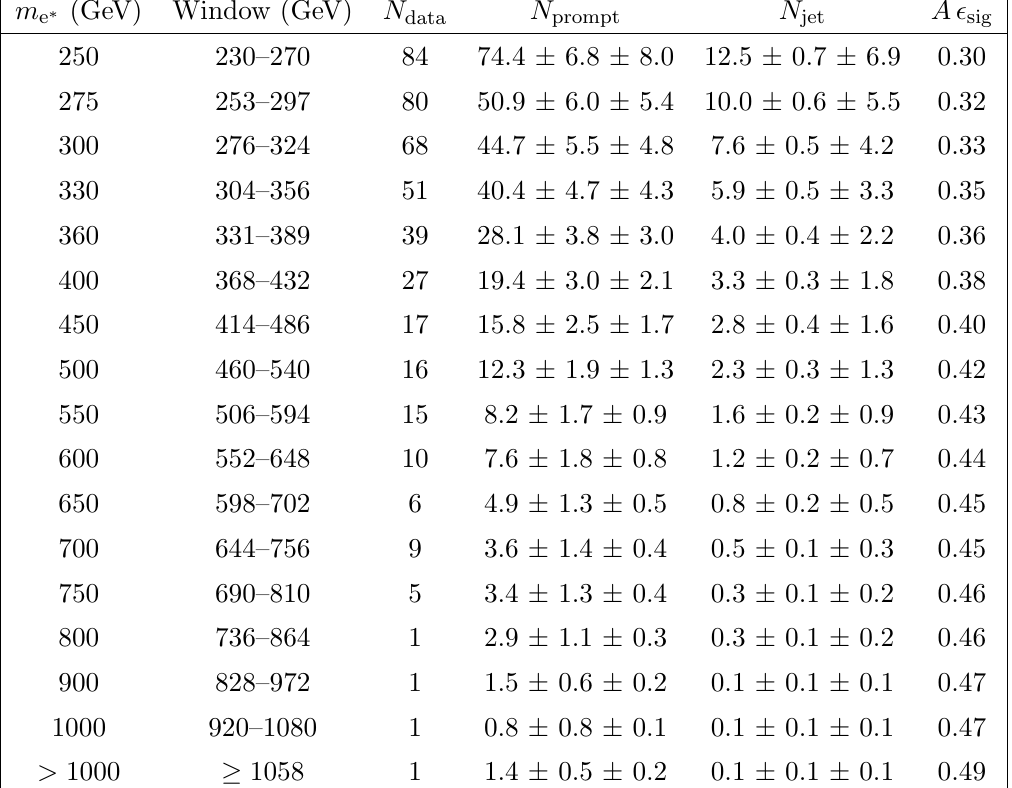
Table 2 . The observed yield and the SM prediction in the search window of the given m ‘ (cid:3) in the ee (cid:13) channel. The symbols N data , N prompt , and N jet represent the number of events in data, the prompt photon background prediction, and the jet background estimate, respectively, together with statistical and systematical uncertainties.